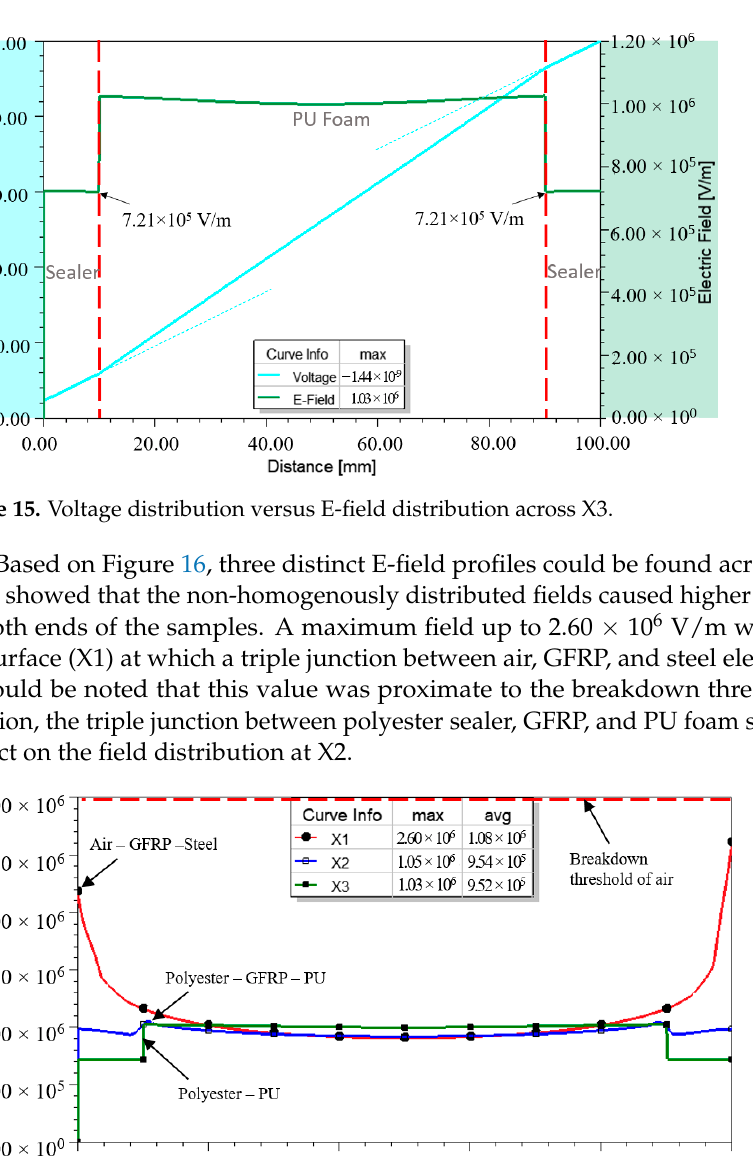
Figure 15. Voltage distribution versus E ‐ field distribution across X3.